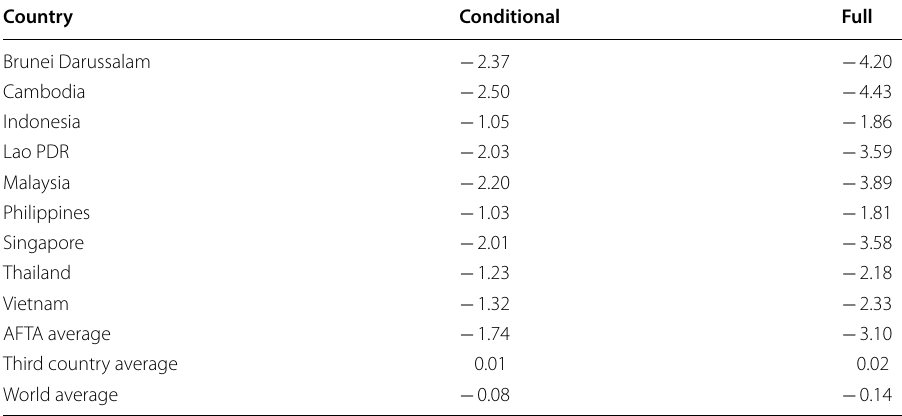
Table 10 Alternative approach to evaluate counterfactual effect of AFTA